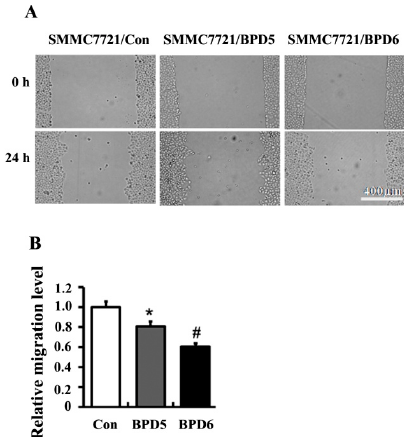
Figure 4. BPDs 5 and 6 suppressed the migration of SMMC7721 cells. 8 × 10 5 cells were seeded in 6-well plates. After 24 h, the confluent cells were scratched with tips. SMMC7721 cells were treated with 5 (1.23 μ g/mL) and 6 (0.4 μ g/mL) for 24 h. The migration of SMMC7721 cells were determined by wound healing assay. ( A ) The images were obtained by microscopy (×20); ( B ) Relative migration levels from ( A ). Data represent as mean ± SD ( n = 3). *, p < 0.05 compared with control group. #, p < 0.05 compared with 5 treatment.